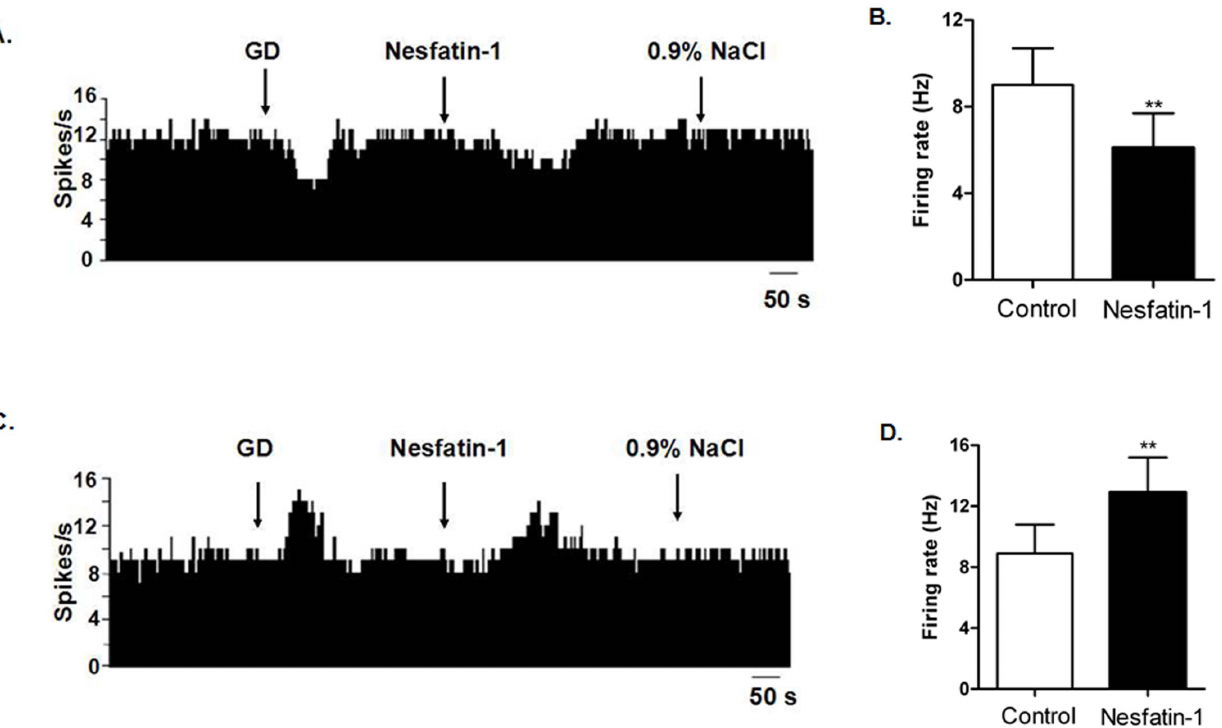
Figure 5. The effect of nesfatin-1 on gastric distension (GD) excitatory (GD-EXC) and inhibitory (GD-INH) neurons in the dorsal vagal complex (DVC). (A).A GD-INH neuron was inhibited by nesfatin-1. The first arrow indicates gastric distention, the second arrow indicates nesfatin-1 (1.5 6 10 2 8 M), and the third arrow indicates 0.9% NaCl-treated control. (B). Changes in firing rate after application of nesfatin-1 (n=16, **P , 0.01). (C). A GD-EXC neuron was excited by nesfatin-1. (D). Changes in firing rate after application of nesfatin-1 (n=32, **P , 0.01).